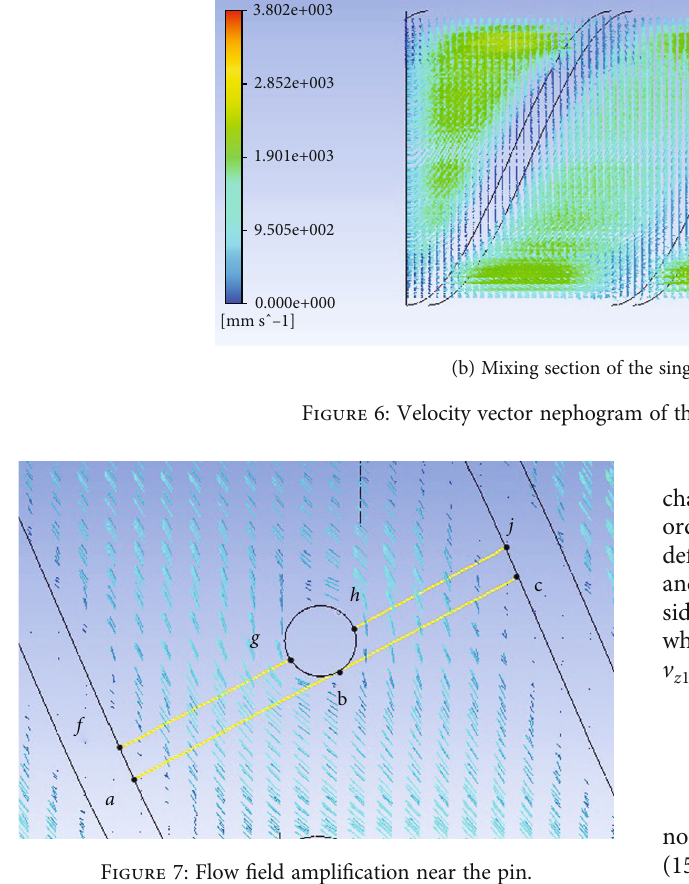
Figure 7: Flow fi eld ampli fi cation near the